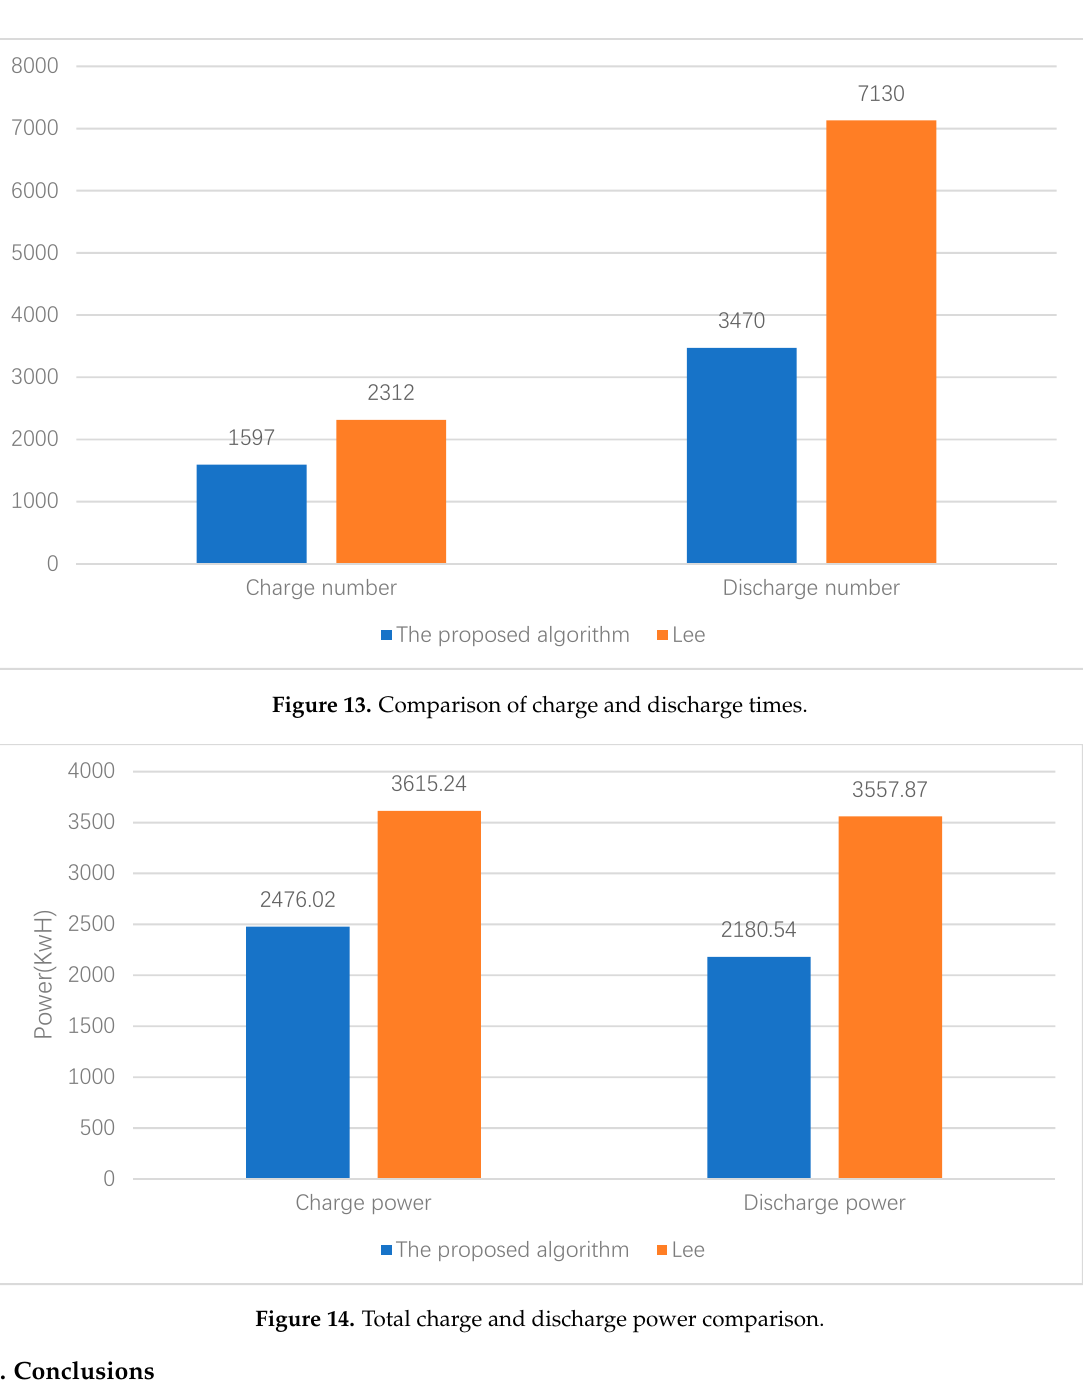
Figure 12. Frequency deviation curve obtained with proposed coordinated control algorithm.